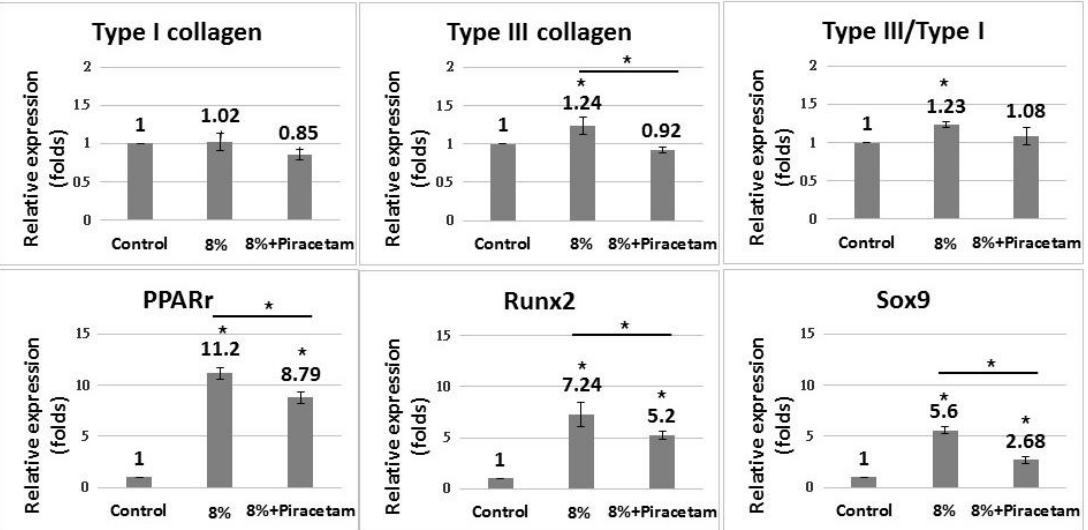
Figure 4. Effect of piracetam on the gene expression of tendon-derived cells (TDCs) subjected to cyclic stretching with 8% strain. Upper panel : Quantitative PCR demonstrated that TDCs with piracetam showed decreased expression of type III collagen genes compared with cells without piracetam. The difference in type III/type I ratio between groups was not significant. Lower panel : TDCs with piracetam showed decreased expression of Pparg , Runx2 , and Sox9 compared with cells without piracetam. Data are expressed in fold-changes of expression level relative to the control (static culture) and presented as mean ± SD ( n = 4, * p < 0.05).